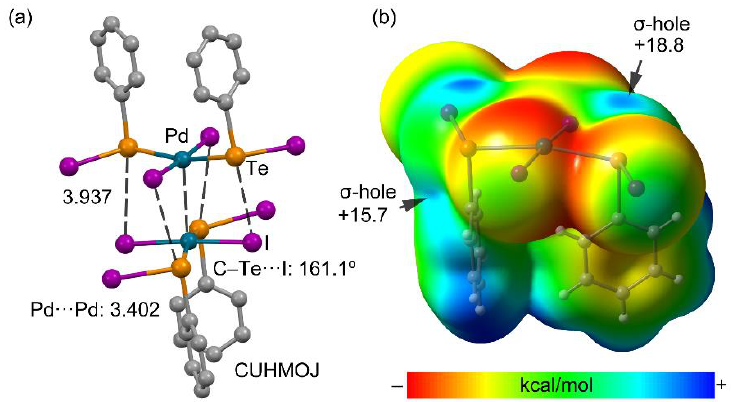
Figure 11. ( a ) Partial view of refcode CUHMOJ structure. Distances in Å. H-atoms omitted for clarity. ( b ) MEP surface (isodensity 0.001 a.u.) of CUHMOJ. The energies at the σ -holes are indicated in kcal/mol.